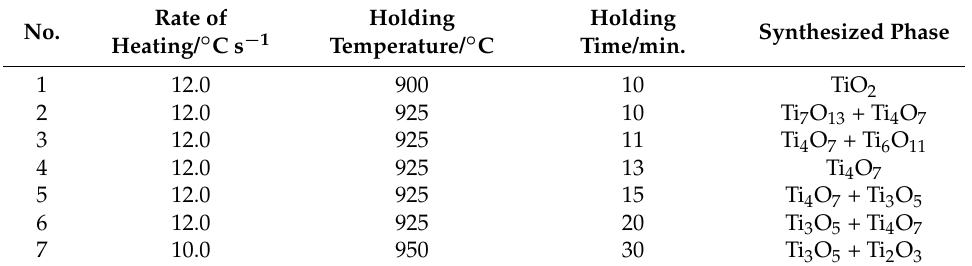
Table 1. Experimental results of various heating regime to synthesize Ti 4 O 7 nanoparticles from Sample 1.